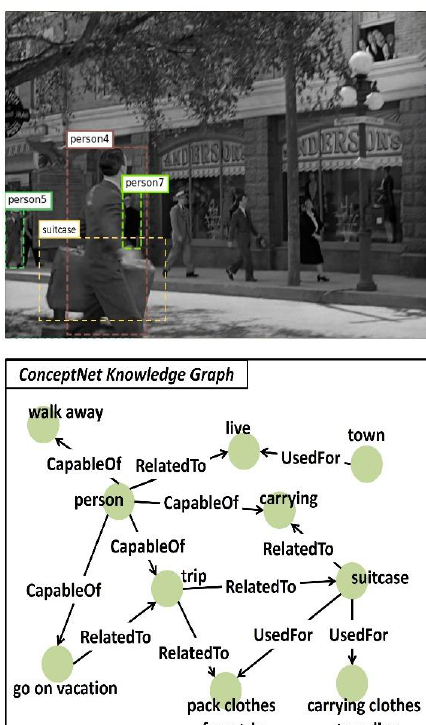
Figure 9. The first example of VCR task performed by the proposed model.